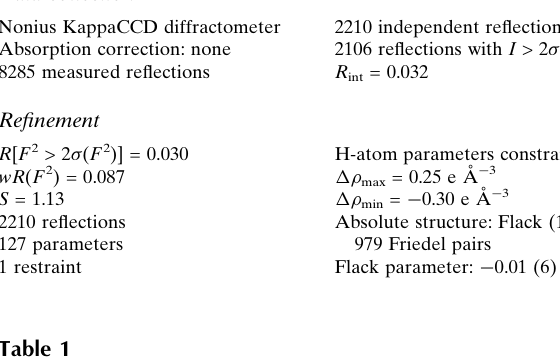
Hydrogen-bond geometry (A˚ , (cid:2)